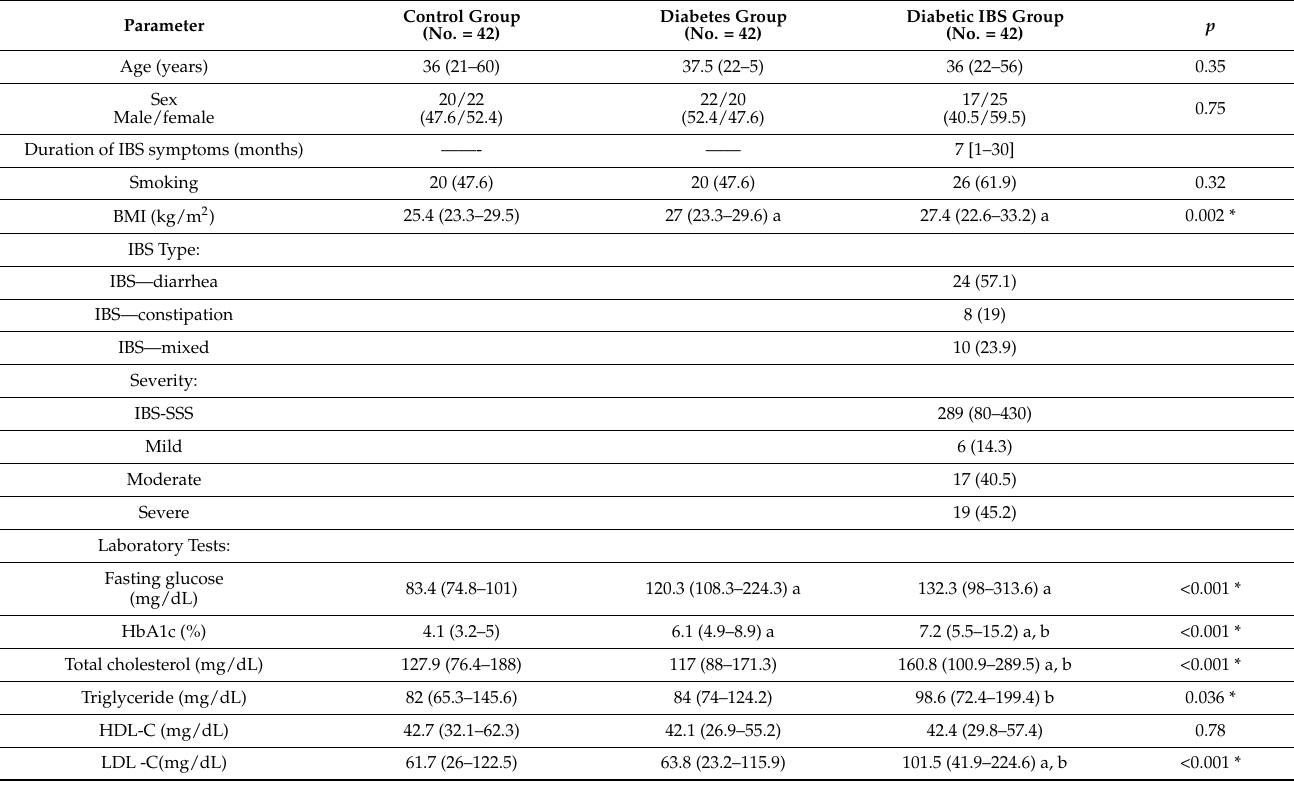
Table 1. Demographic, clinical, and biochemical characteristics of the studied